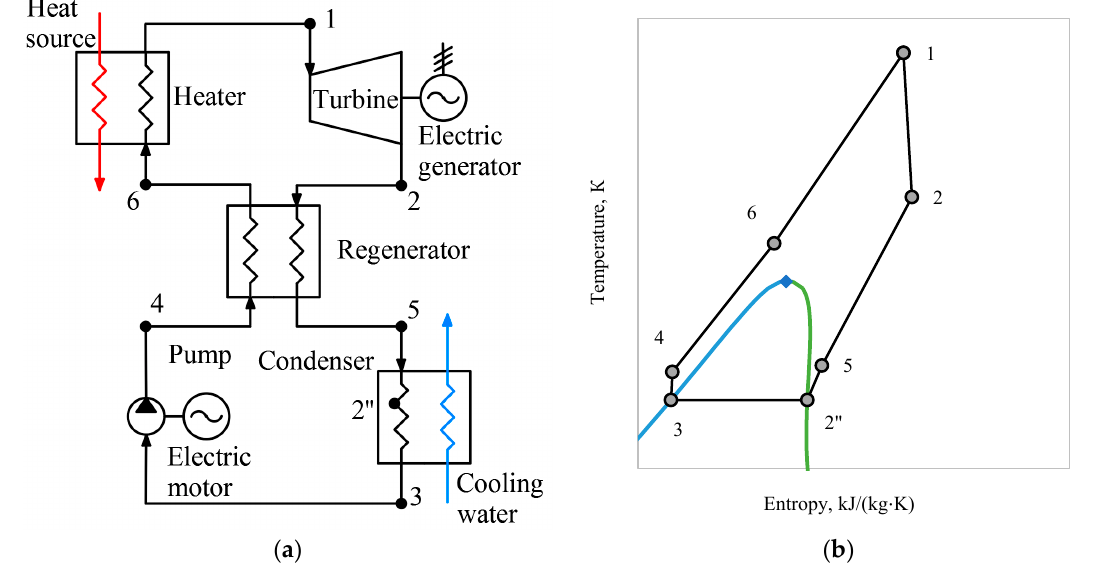
Figure 7. Rankine cycle with regeneration: ( a ) Scheme; ( b ) Cycle.